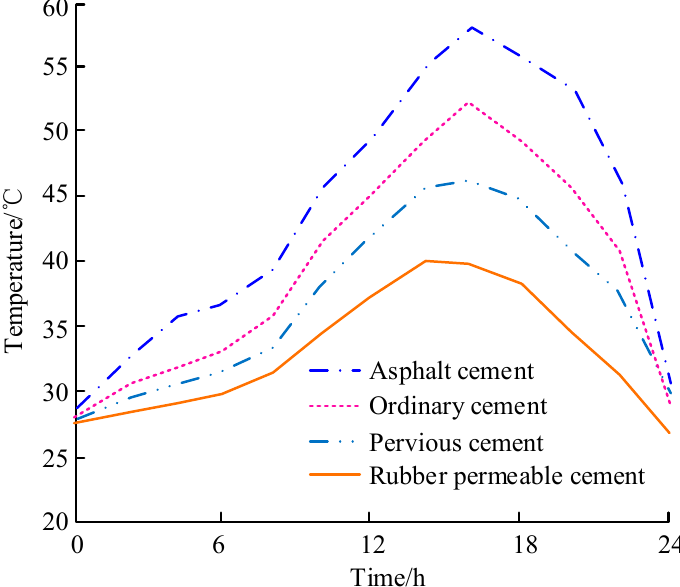
Figure 7. Comparison of temperature changes under different concrete types.